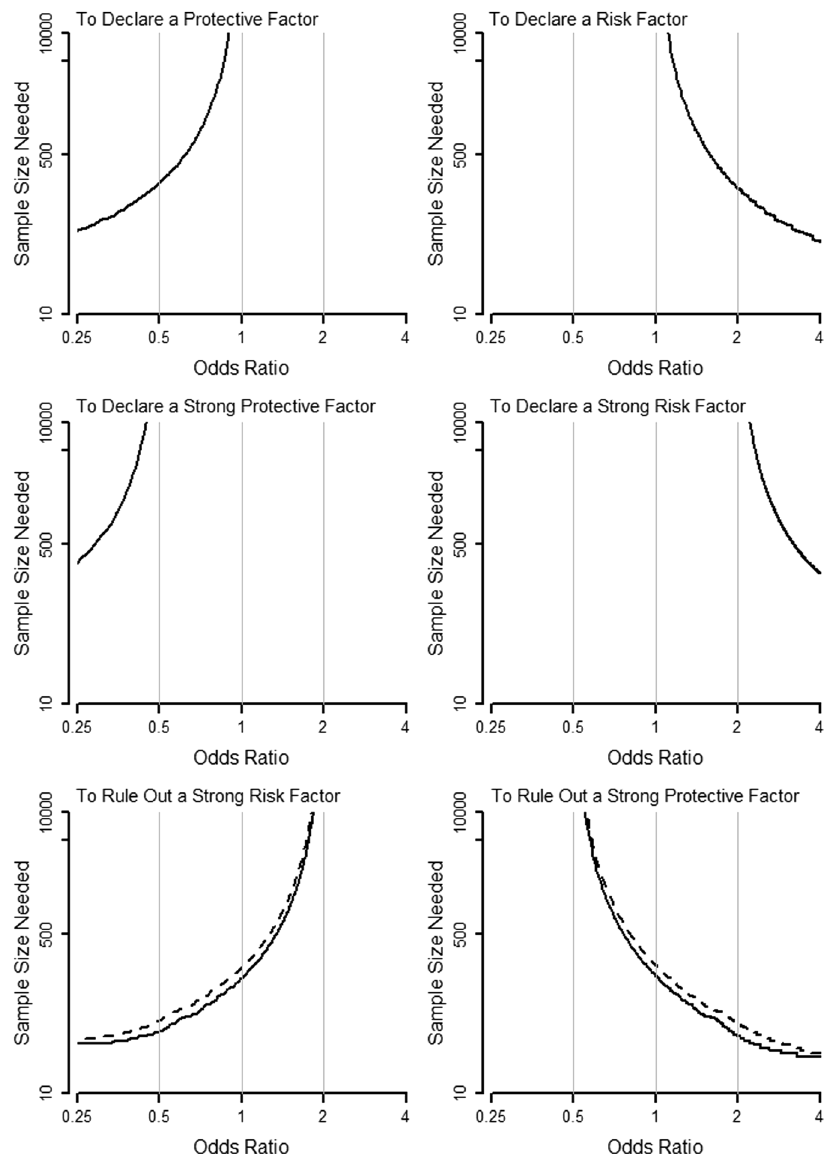
Figure 3. Sample sizes needed for the various conclusions (solid lines: the five-region method; dashed lines: the classical